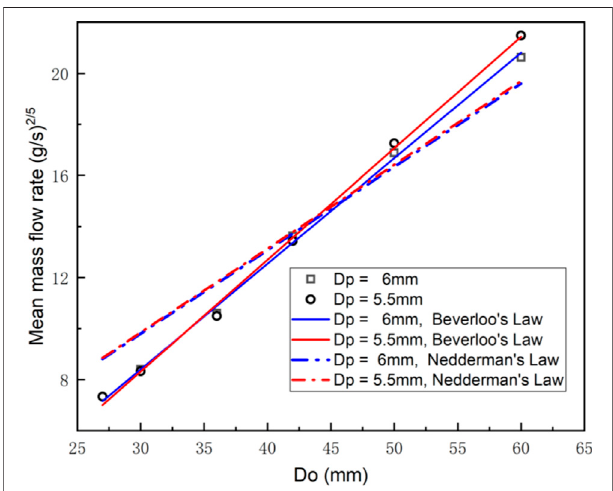
FIGURE 5 | Two sets of fi tted lines of two sets of particles at different ori fi ces.